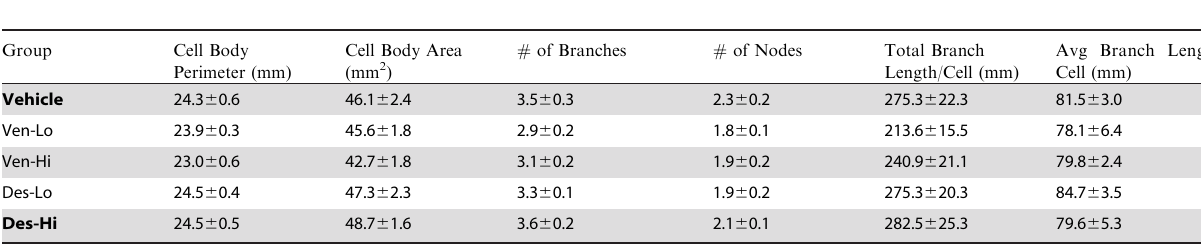
Table 3. Morphometric Analysis of BrdU/DCX +